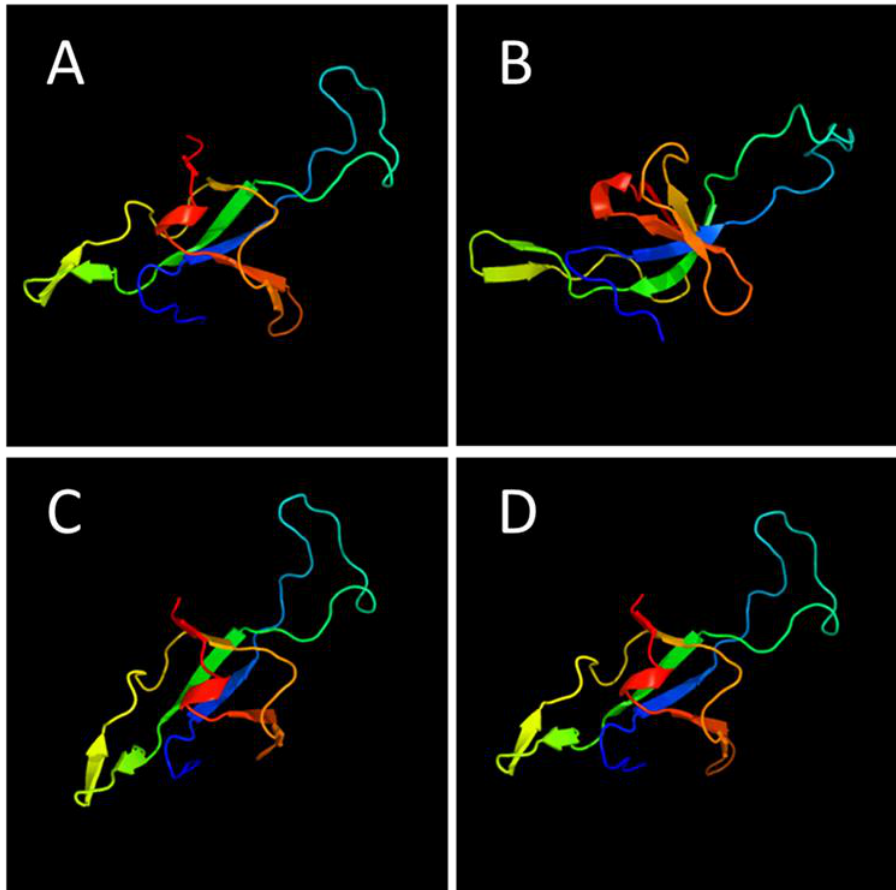
Figure 5. Comparison of predicted tertiary structure of the heat shock protein GrpE as identified in B. sporothermodurans strains SA01, SAD, BR12, DSM 10599, and B4102 ( A ), B . oleronius DSM 9356 ( B ), B . cereus ATCC 10987 ( C ), and B . subtilis subsp. subtilis str. 168 ( D ). Models were predicted using the Phyre2 suite of tools and at 100% model confidence for all four protein structures. Protein sequence alignment was performed with BioEdit v. 7.2.1.